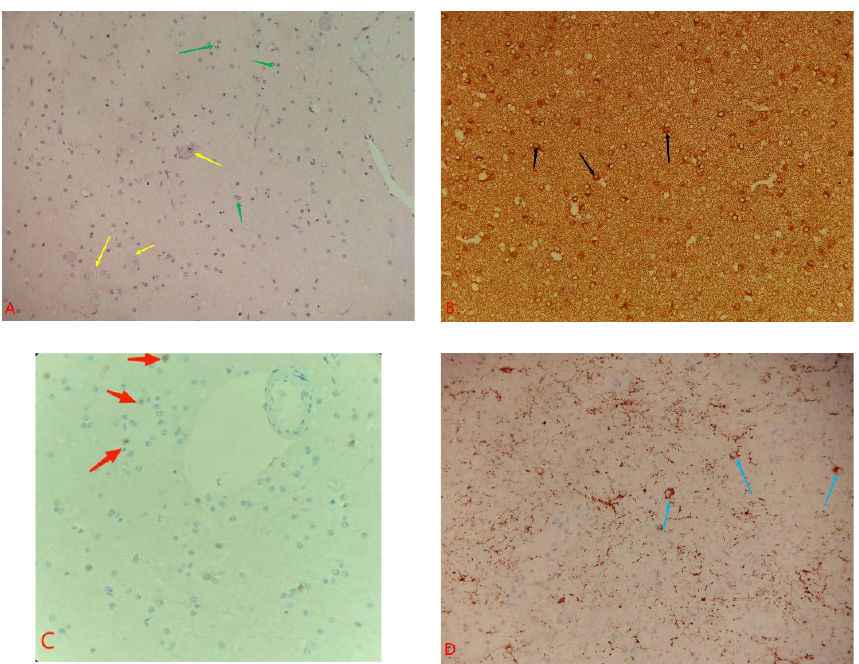
Figure 3. The pathological staining of tumors. ( A ) Hematoxylin and eosin-stained section showing a large number of astrocytes (green arrows) and ganglion cells (yellow arrows) with large nucleoli were scattered. ( B ) The cytoplasm of glial cells shows positive staining for GFAP (black arrows). ( C ) A few NEUN-positive nuclei are visible (red arrows). ( D ) Syn staining reveals the positive cytoplasmic staining of neoplastic neurons (blue arrows).